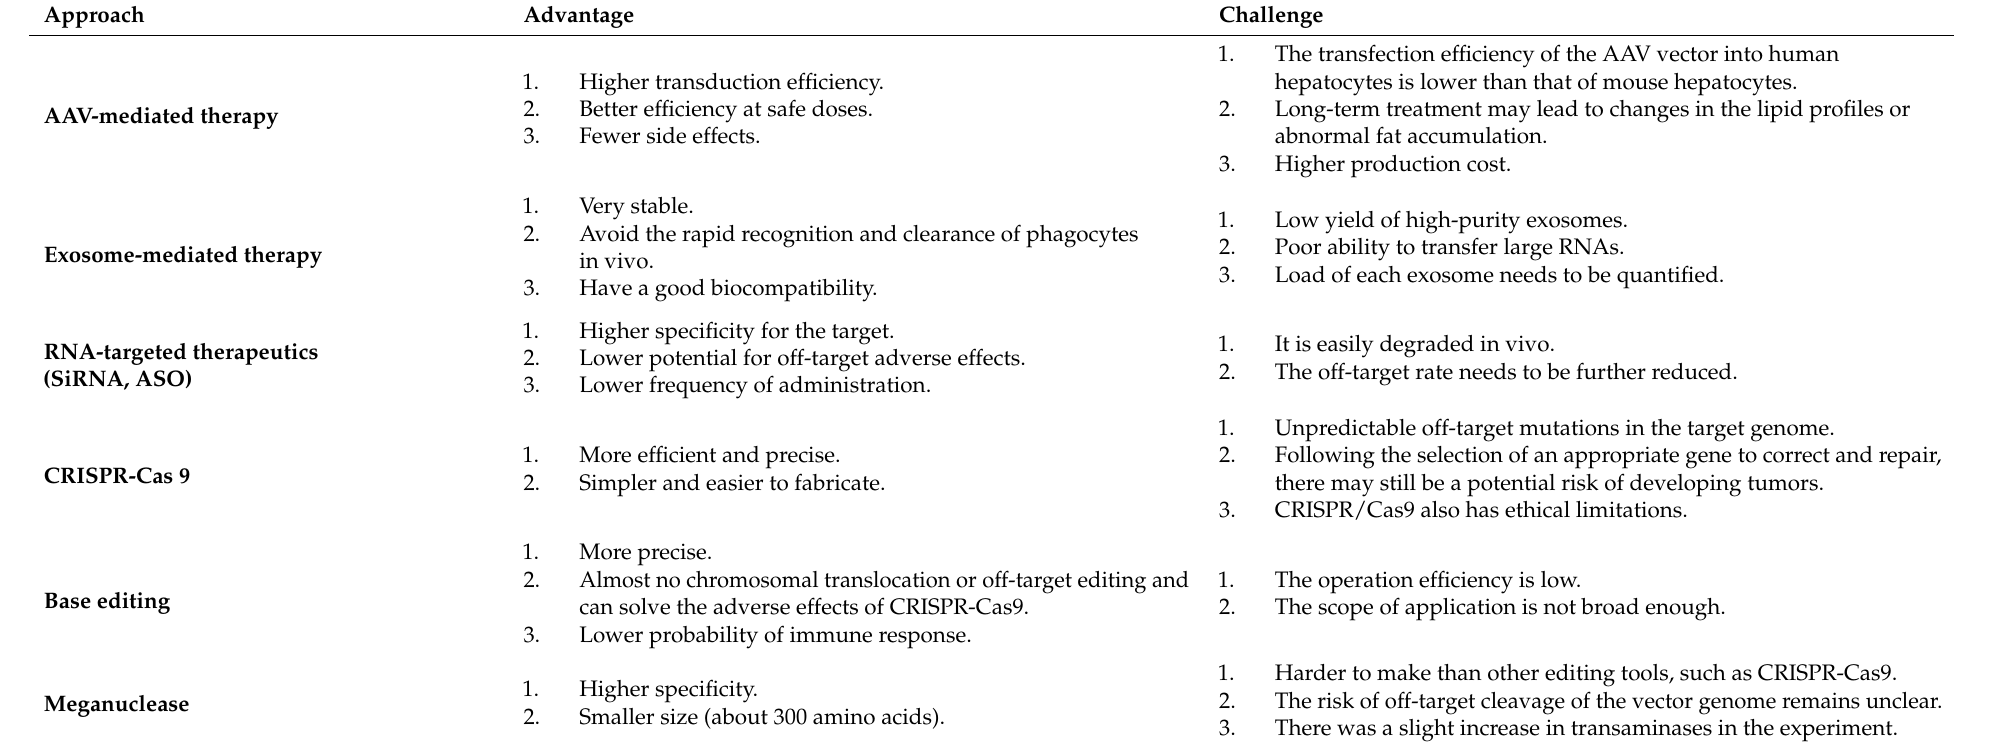
Table 2. The advantages and challenges of the different